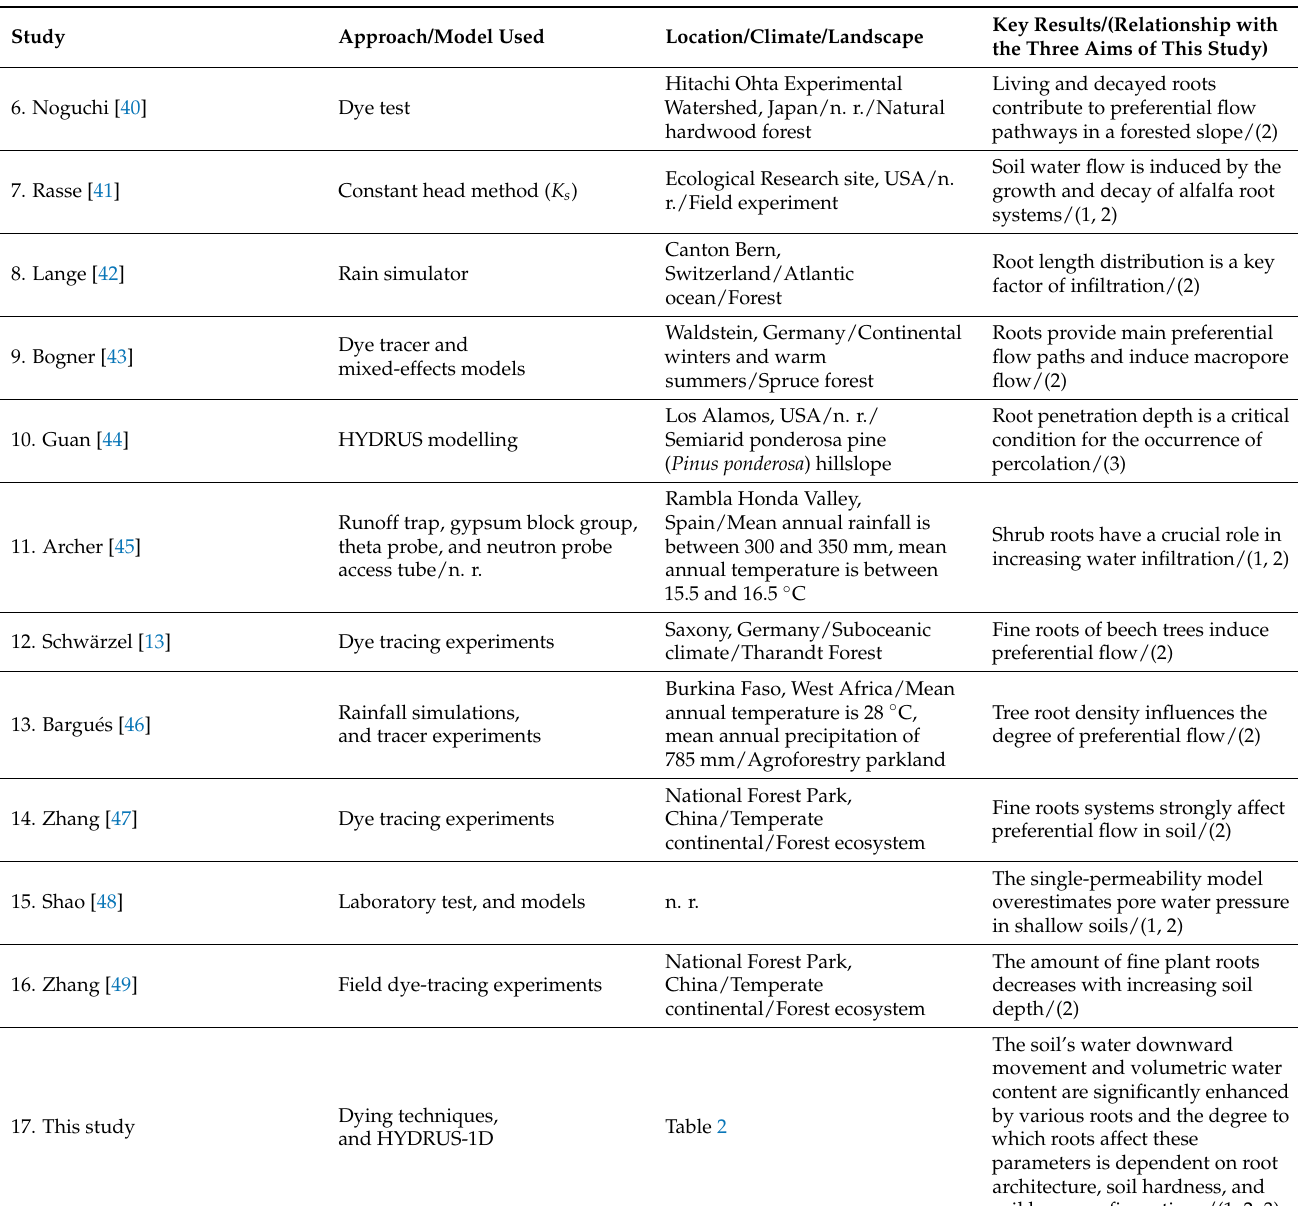
The soil’s water downward movement and volumetric water content are significantly enhanced by various roots and the degree to which roots affect these parameters is dependent on root architecture, soil hardness, and soil layer configurations/(1, 2,